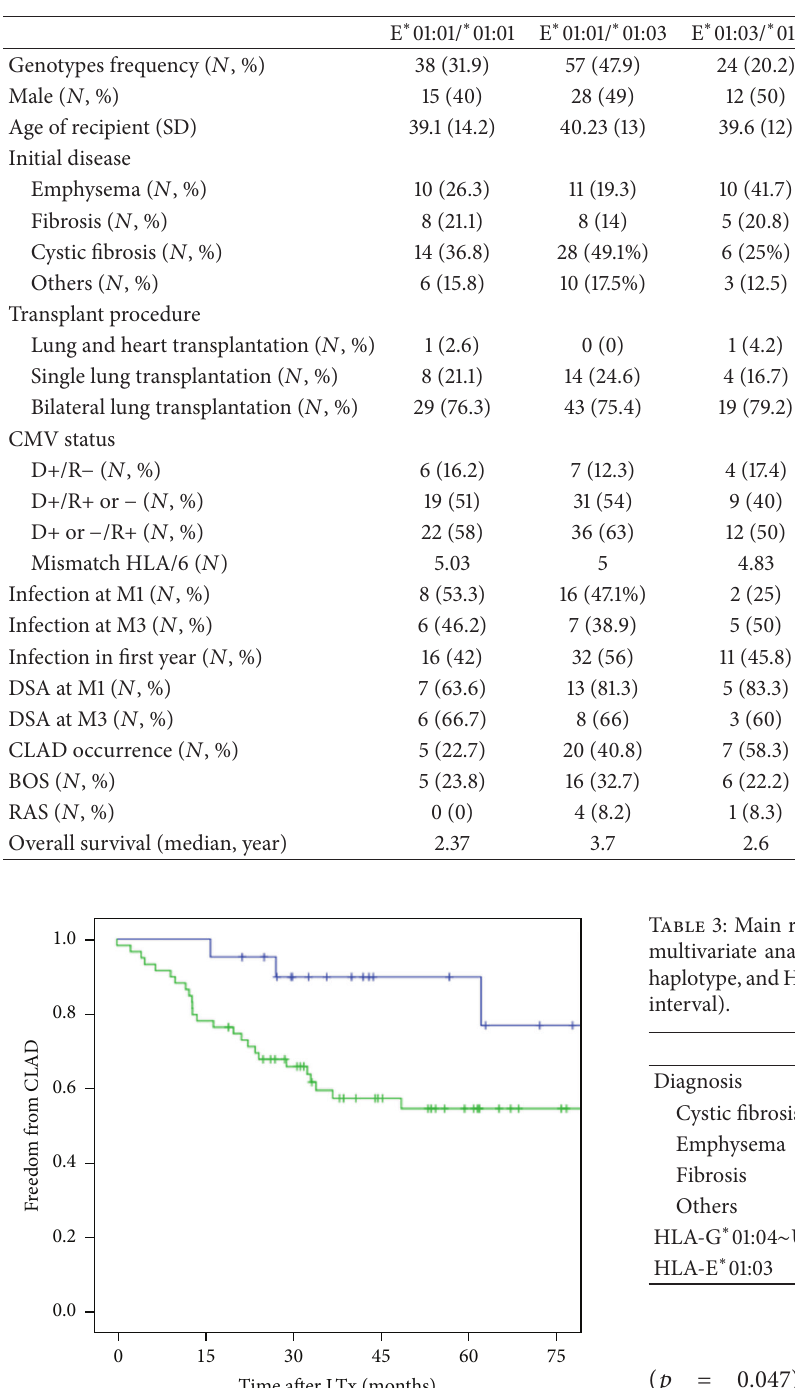
Table 2: Baseline comparison of distribution and risk factors for 119 patients who underwent LTx according to HLA-E genotypes.